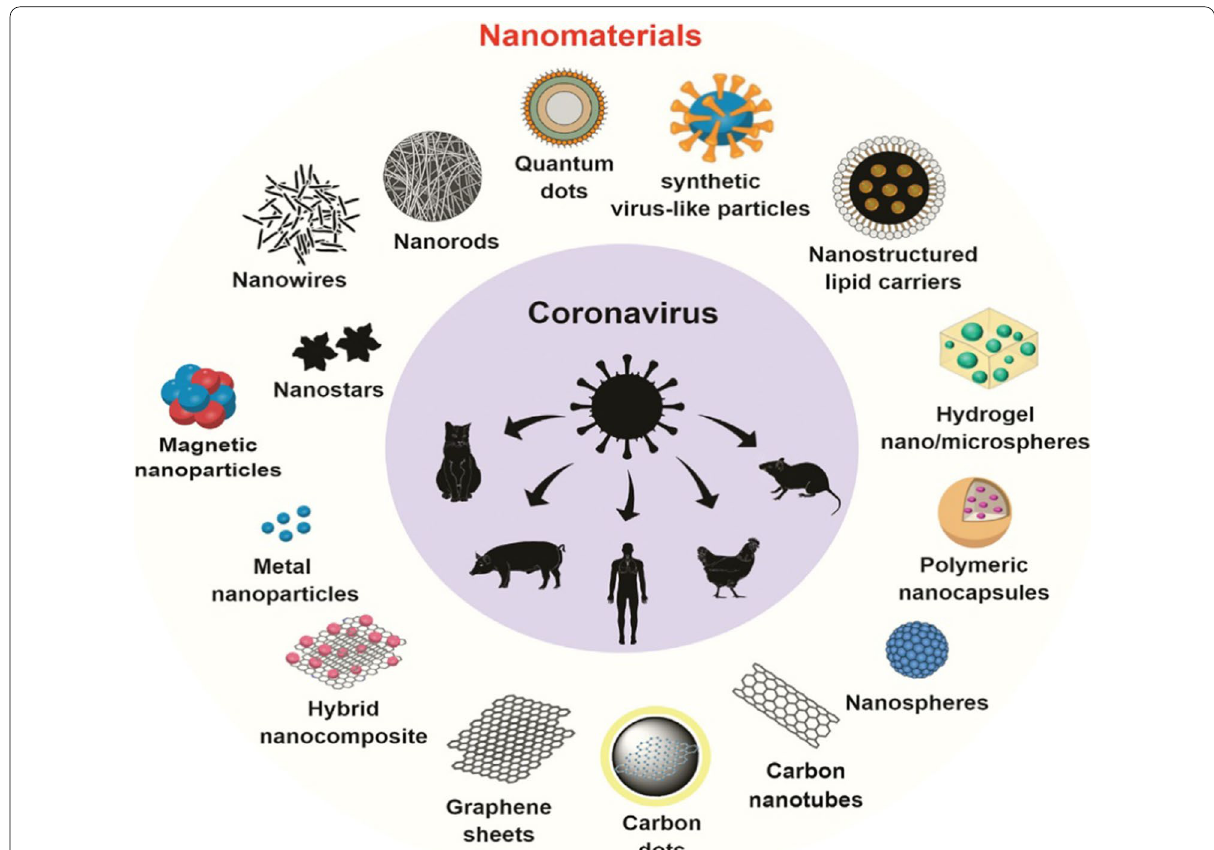
Fig. 1 The most common nanomaterials with antiviral activity against animal/human COVs including the novel SARS ‐ CoV ‐ 2. Reproduced from Ref.